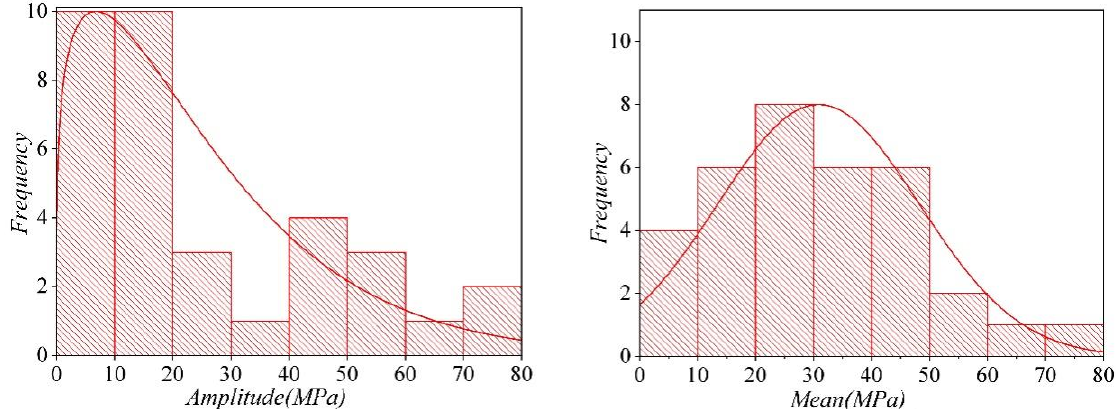
Figure 9. Distribution fitting of load amplitude and mean.